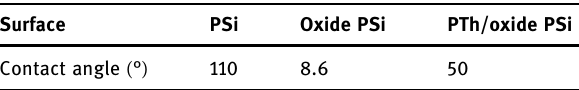
Table 1: Contact angle values of the before and